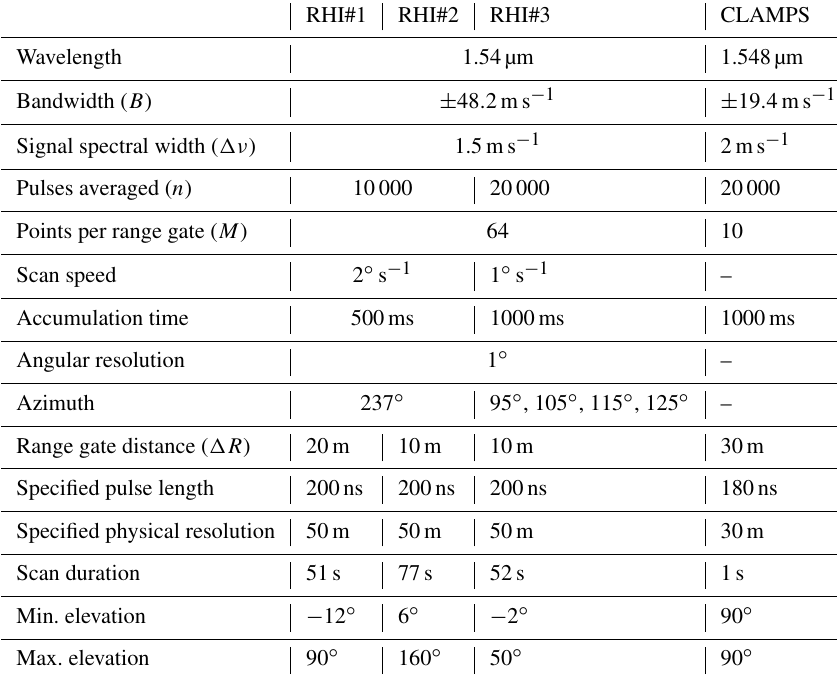
Table 1. Main technical specifications of the scanning